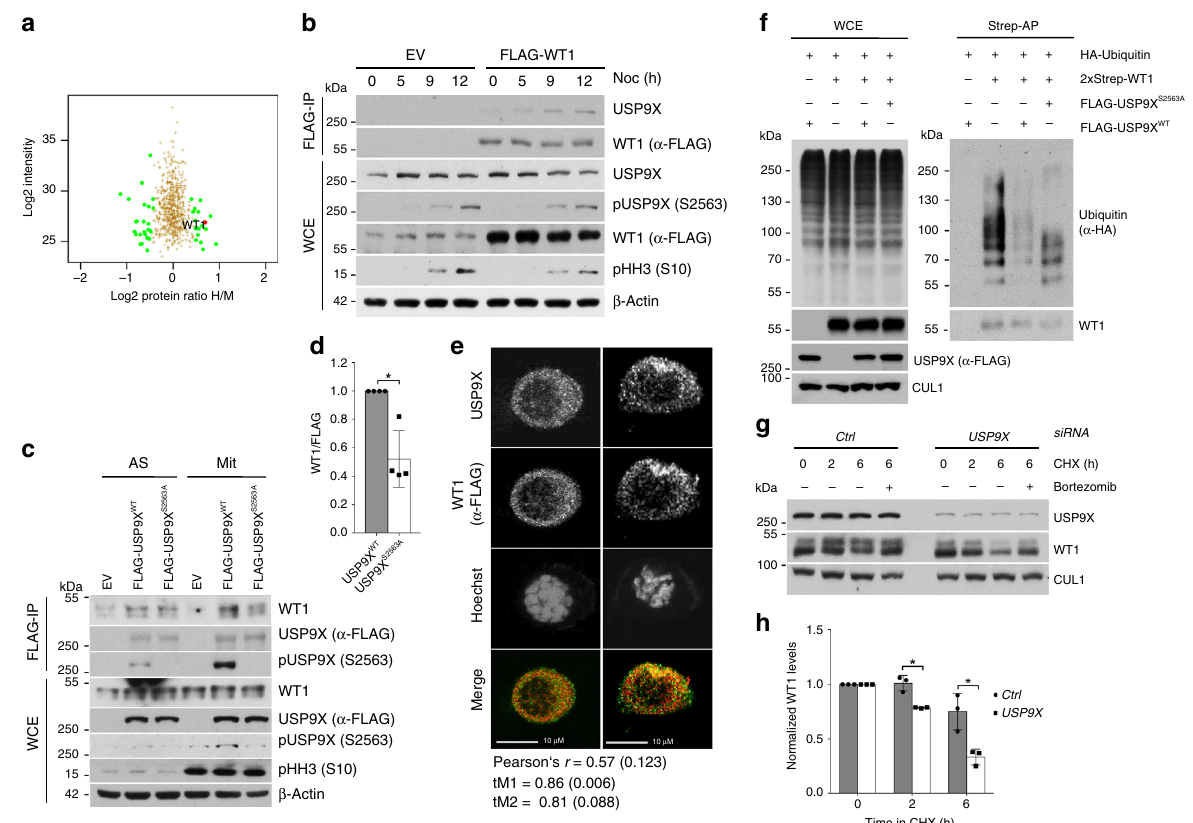
Fig. 2 WT1 is a substrate of pUSP9X (serine 2563) in mitosis. a Mass spectrometric analysis of the USP9X-dependent ubiquitome in mitotic HEK 293T cells. USP9X knockdown cells were cultured in heavy ( “ H ” ), control knockdown cells in medium ( “ M ” ) SILAC media. b Co-immunoprecipitation of FLAG-tagged WT1 with endogenous USP9X from HEK 293T cells (EV, expression vector). Cells were exposed to nocodazole, collected, lysed (WCE, whole cell extracts), and subjected to anti-FLAG immunoprecipitation before analysis by western blot. c Co-immunoprecipitation of USP9X WT rather than USP9X S2563A with WT1. Expression vector (EV), FLAG-tagged USP9X WT or USP9X S2563A was overexpressed in asynchronous (AS) or mitotically arrested (Mit, 15 h nocodazole) HEK 293T cells, and puri fi ed by immunoprecipitation before western blot analysis. d Quanti fi cation of WT1 co-immunoprecipitated with either USP9X WT or USP9X S2563A from n = 4 biologically independent experiments as described in c . Ratio paired t -test was applied with * p = 0.0248. e Immuno fl uorescence imaging of mitotic U2OS cells showing colocalization of WT1 (red) and USP9X (green) in two representative mitotic cells. Cells were transfected with FLAG-tagged WT1 and arrested in mitosis using nocodazole (15 h) before fi xing and staining. Values for Pearson ’ s and Manders ’ coef fi cients (tM1 and tM2) are the mean and SD calculated from n = 17 biologically independent cells. Scale bar, 10 µ m. f In vivo ubiquitylation assay showing pUSP9X-dependent ubiquitylation of WT1. HEK 293T cells transfected with FLAG-tagged USP9X WT or USP9X S2563A , 2xStrep-tagged WT1, and HA-tagged Ubiquitin were synchronized in mitosis using nocodazole. Fourteen hours before collection nocodazole, bortezomib, and the caspase inhibitor Z-VAD-FMK were added. Cells were lysed under denaturing conditions and 2xStrep af fi nity puri fi cation was performed. g Cycloheximide time course showing USP9X-dependent WT1 stability. U2OS cells were treated with control or USP9X siRNA and arrested in mitosis using sequential thymidine and nocodazole (11 h). Mitotic cells were collected by shake-off and cycloheximide, bortezomib (where indicated), and Z-VAD-FMK added before collection and western blot analysis. h Quanti fi cation of WT1 protein levels from n = 3 biologically independent experiments as described in g . Western blot bands of WT1 were quanti fi ed using ImageJ software and normalized to loading control and time point 0. One sample t -test was applied with * p = 0.0219; * p = 0.0389. Throughout this fi gure mean and standard deviations as error bars are